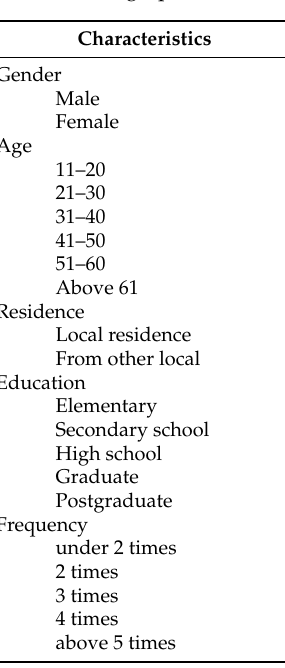
Table 1. Demographic characteristics of the respondents.